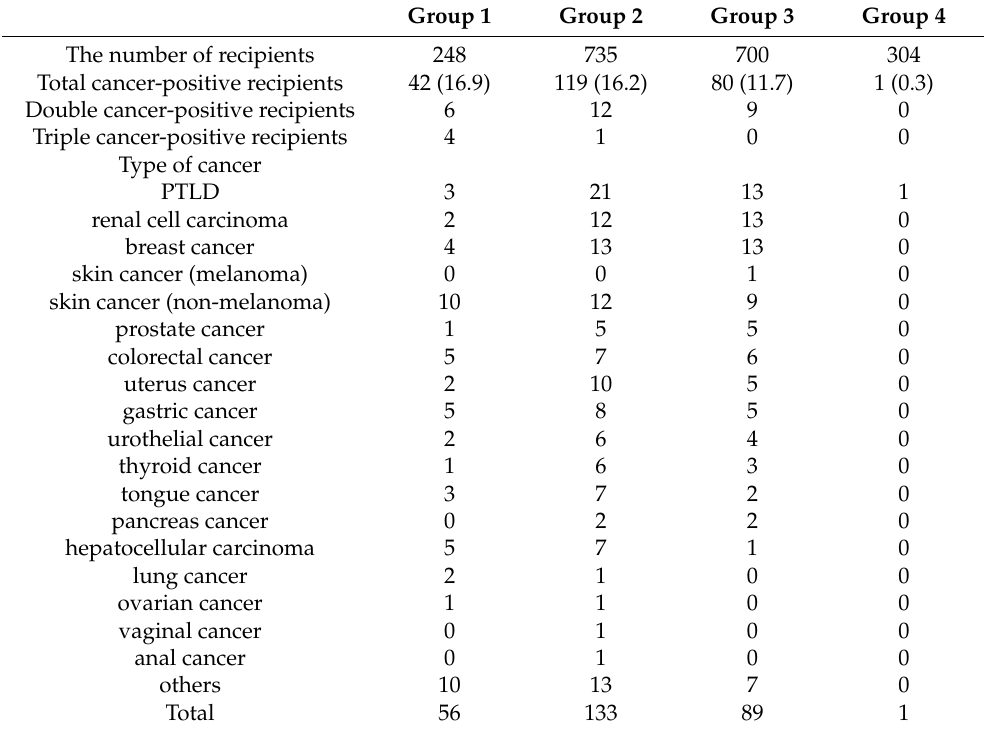
Table 3. Distribution of cancer